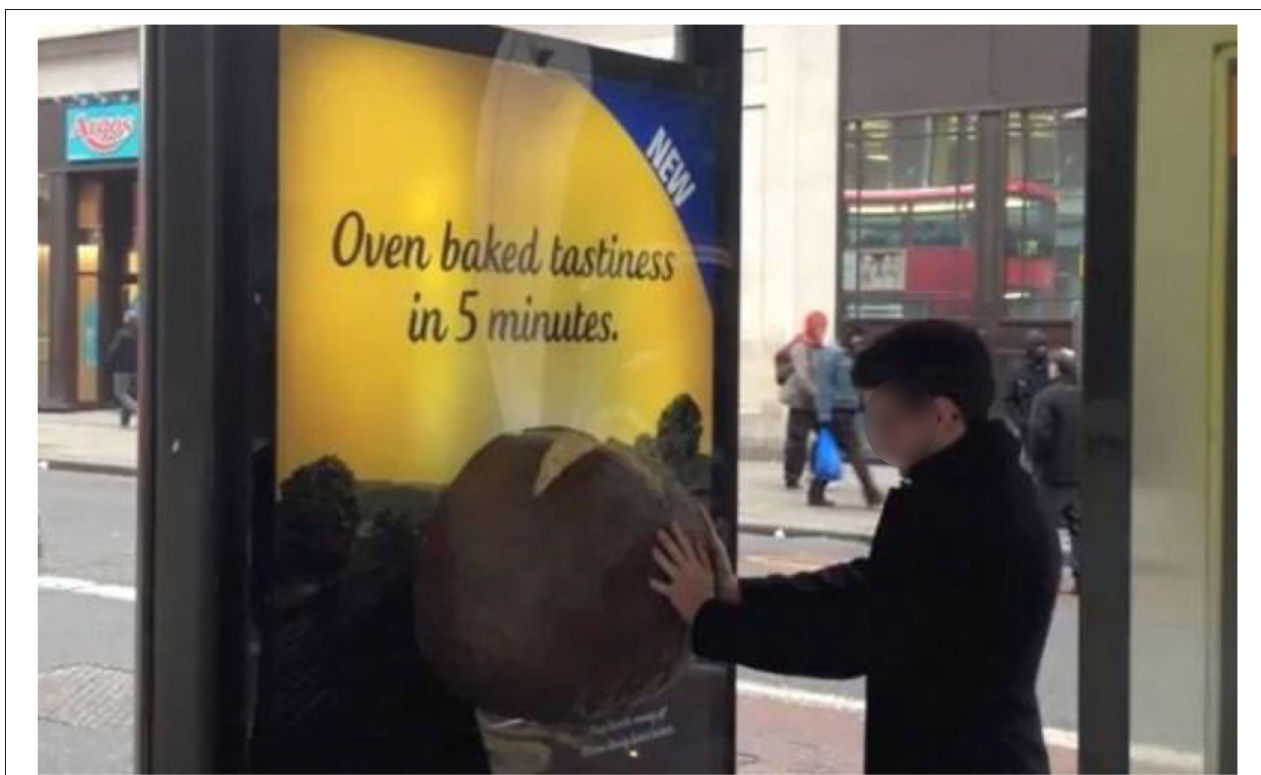
FIGURE 3 | Touch the tattie and smell that delicious oven-baked potato smell. Multisensory marketing at a London